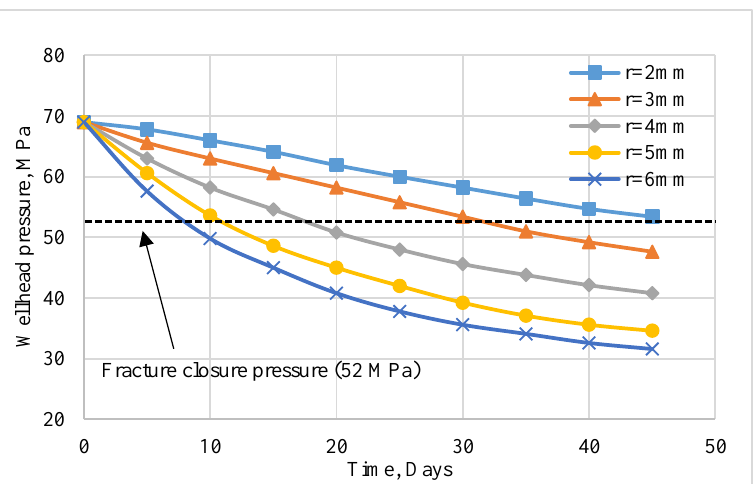
Figure 11—Wellhead pressure in the fracture with various choke